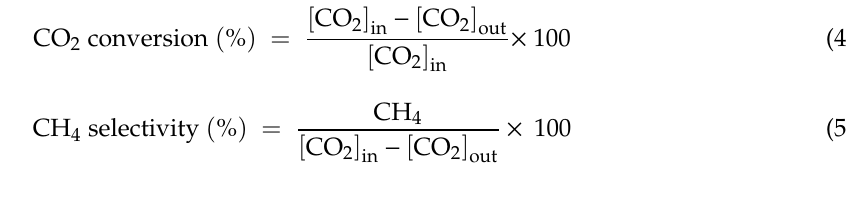
Supplemental Figure S1: Isotherm and pore size distribution (inset) of Ni-Ce-ZrO2 catalysts, Supplemental Table S1: XPS core level electron binding energy of Ni-Ce-ZrO δ catalysts for di ff erent Ni content, Supplemental Figure S2: The stability of Ni6.0 catalyst at 300 ◦ C for 48 h, Supplemental Figure S3: TEM images of (a) fresh and (b) spent Ni6.0 catalysts. Reaction conditions: GHSV = 10,000 h-1, H2 / CO2 = 4, reaction temperature = 300 ◦ C and reaction time 30